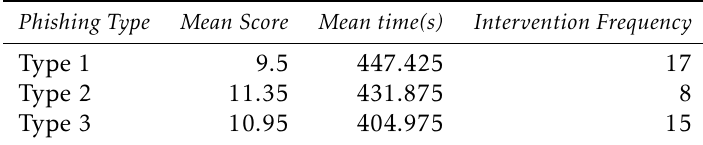
Table 5. Different Types of Phishing Score and Time